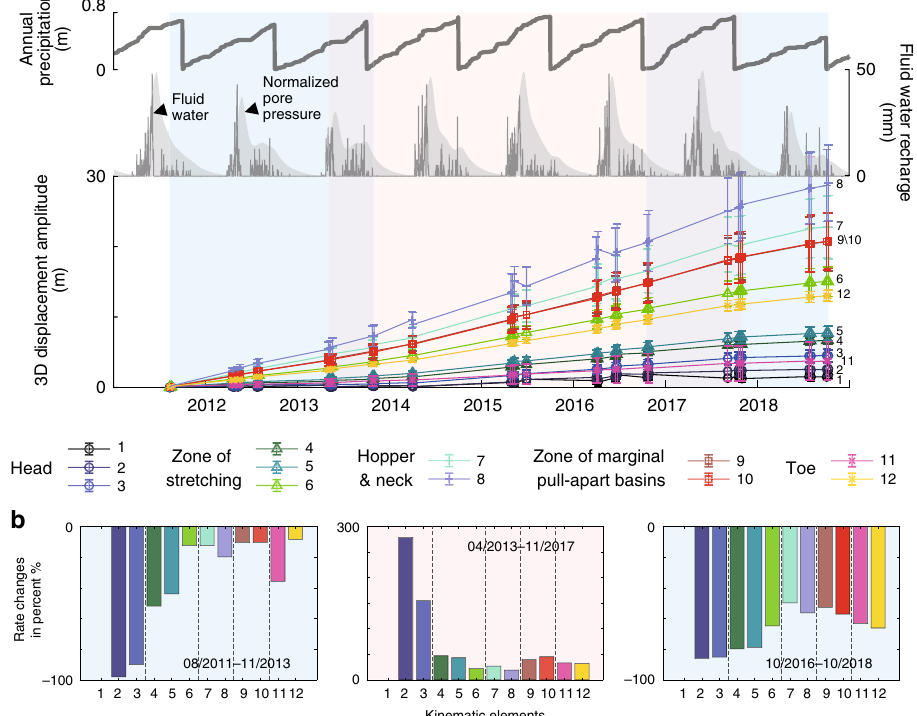
Fig. 5 Multi-annual landslide motions from UAVSAR hybrid InSAR-POT analysis. a The annual precipitation observations, the estimated water recharge at the surface, and the normalized pore pressure at 20-m depth are shown in gray thick, thin lines and shades, respectively. 3D displacement amplitude for each kinematic element in indicated colors and with number labels to the right (1 – 12). The error bars represent 1 standard deviation of the cumulative displacements for the targets in each kinematic element. Blue and red shades on the background show the time periods of observed deceleration and acceleration, respectively, consistent with the meteorological data. b Multi-year rate changes in three respective periods for the kinematic elements 1 –